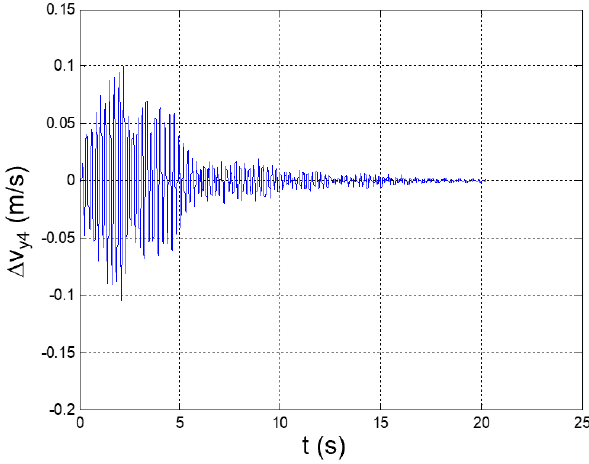
Figure 17. Seismic response, interstory speed at the 3rd floor ( Δ 𝑣 y3 = 𝑣 y3 − 𝑣 y2 ).